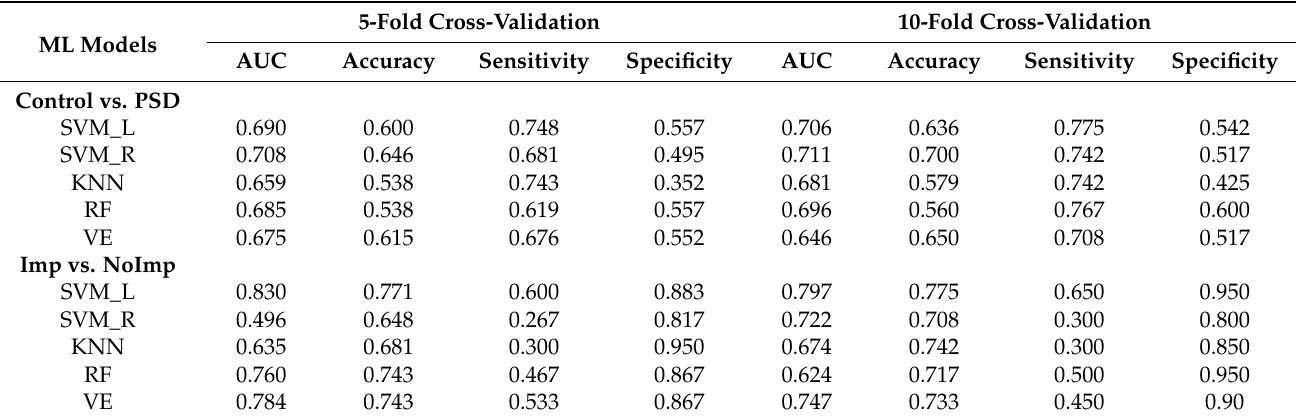
Table 9. AUC, accuracy, sensitivity, and specificity of each ML algorithm.